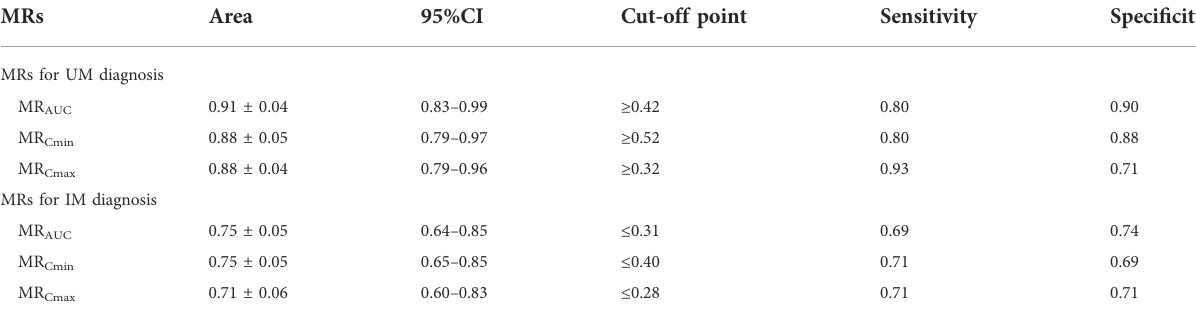
TABLE 4 The diagnostic cut-off points of MRs for distinguishing UMs or IMs from other